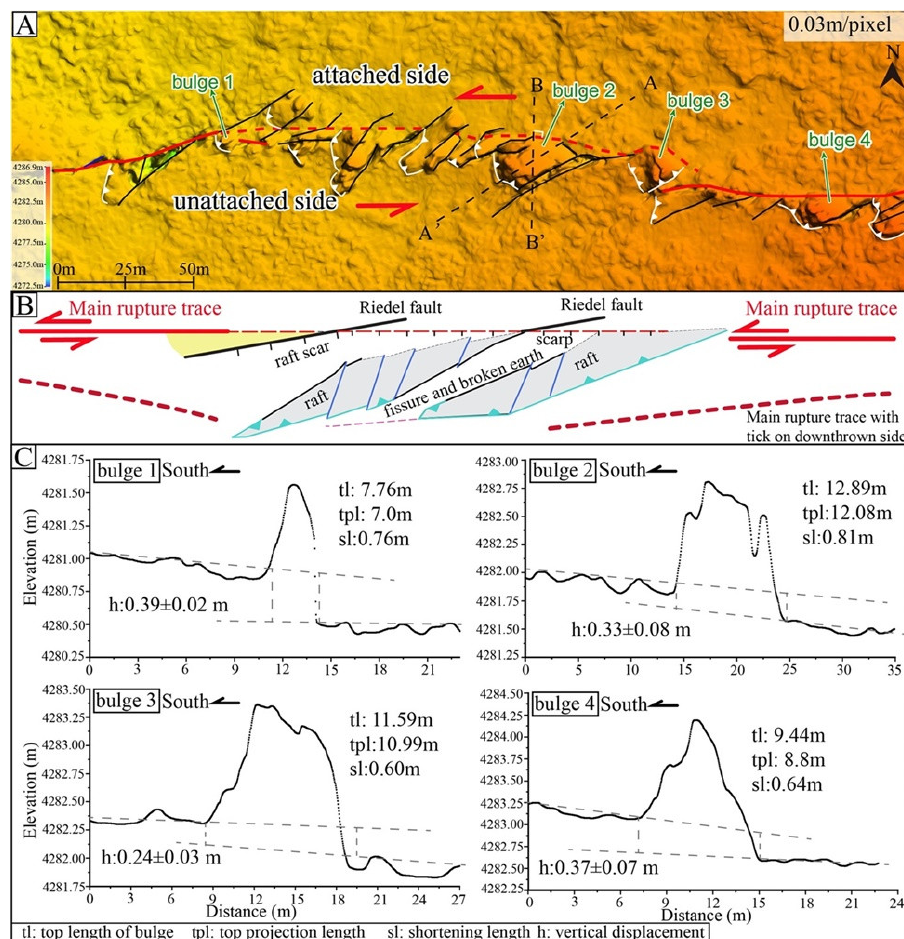
Figure 11. ( A ) High-resolution DSM of bulges in the South Eling Lake rupture segment. ( B ) Simplified diagram of mole track. AA’ is the profile of the long axis of the bulge and the BB’ is the profile perpendicular to the fault trace through the bulge vertex. The rafts are relatively pinned from one fault block “attached side” (northern block) and “unattached side” (southern block) to the other, from which they are thrust outward along a contractional fault. ( C ) Figures showing the bulge profiles extracted from DSM, the measurement of vertical scarp height, and the calculated horizontal shortening.